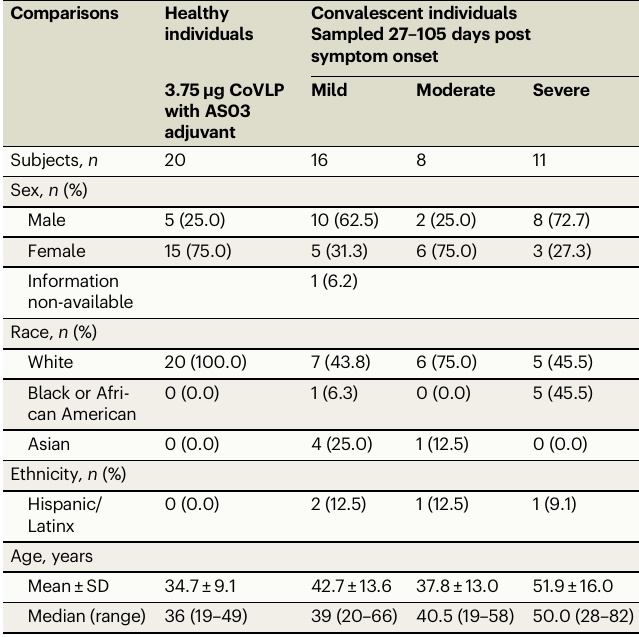
Table 1 | Summary demographics and baseline characteristics of the trial subgroup of participants who received 3.75 µg CoVLP adjuvanted with AS03 (NCT04450004) and patients convalescing from